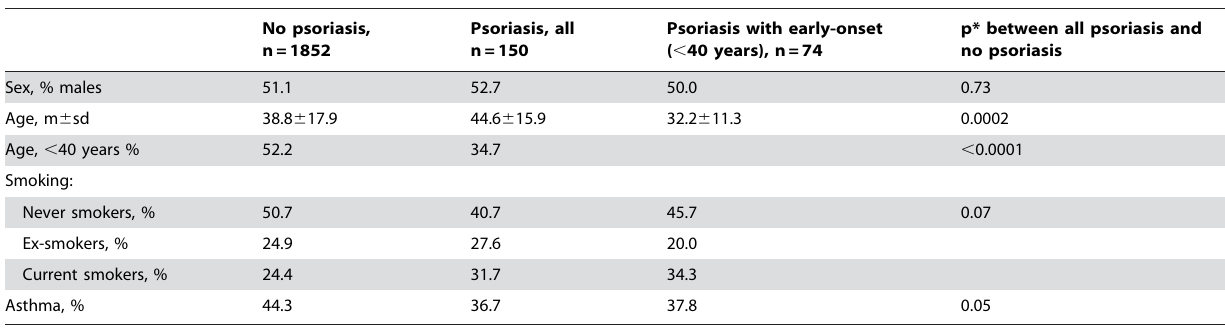
Table 1. Description of the population.